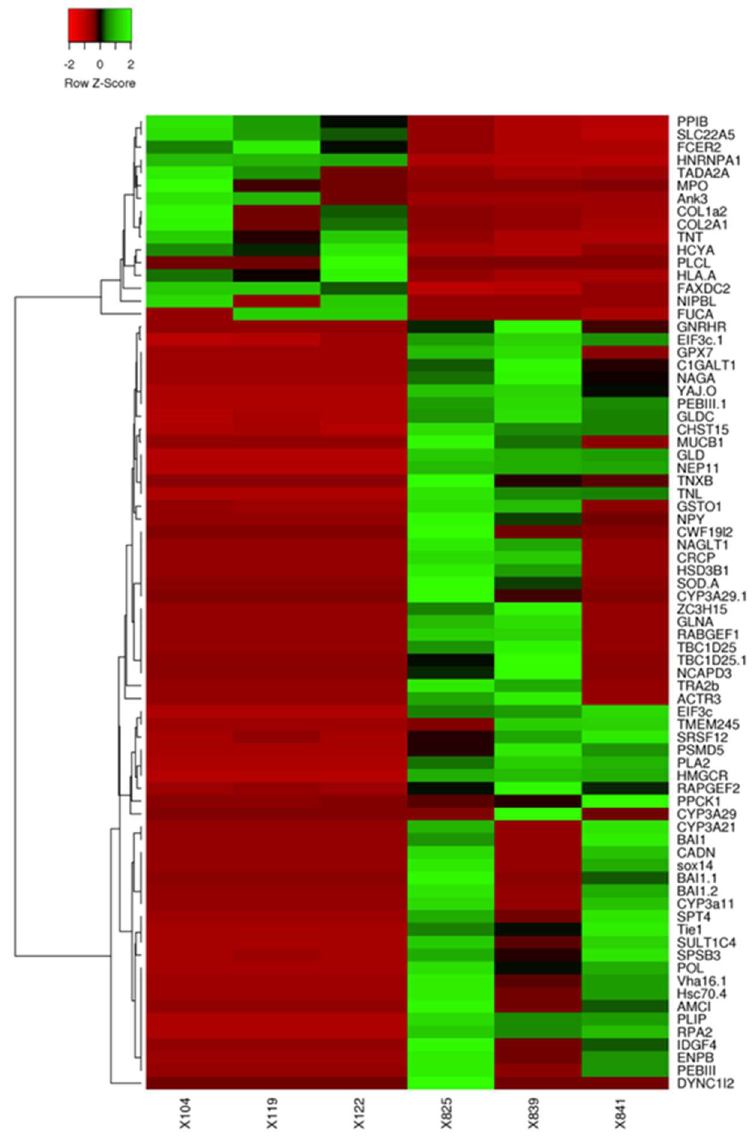
Figure 4. Heatmap of transcripts with an expression change greater than four-fold. The samples X104, X119, and X122 belong to the ganglia of mature abalone, whereas X825, X839, and X841 belong to the immature abalone. The up and downregulated transcripts are indicated by green and red, respectively.